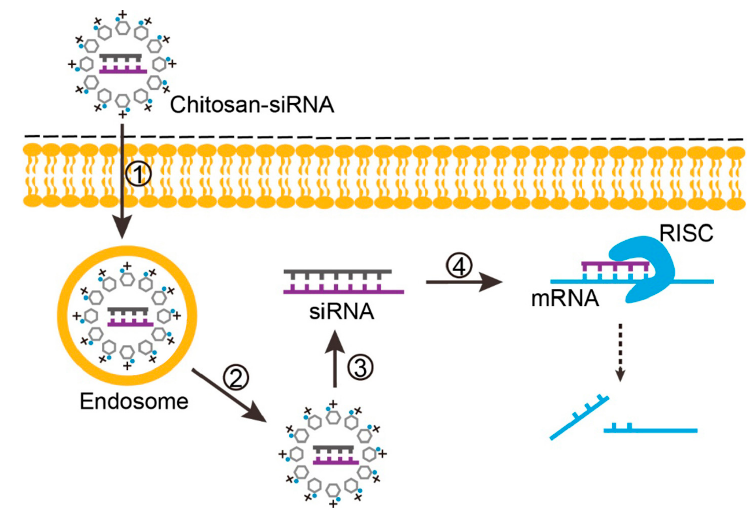
Figure 6. Cellular events associated with chitosan-based siRNA delivery for target gene silencing. 1, Cellular uptake of chitosan–siRNA by endocytosis. 2, Endosomal escape of chitosan–siRNA. 3, Dissociation of siRNA from chitosan. 4, siRNA association with RISC and target mRNA by base pairing, resulting in target mRNA cleavage and/or translation repression, and subsequent inhibition of protein synthesis.